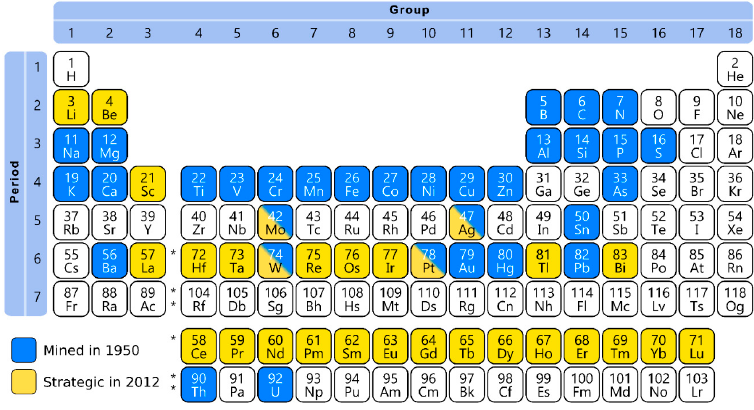
Figure 1. The need of minerals through time (adapted from [7]).